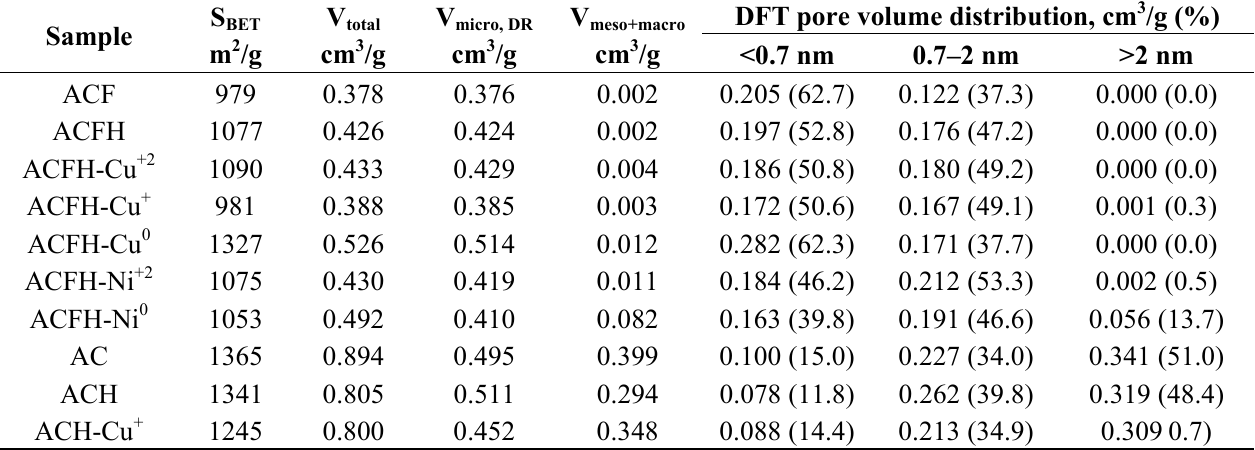
Table 2. Surface area and porosity of